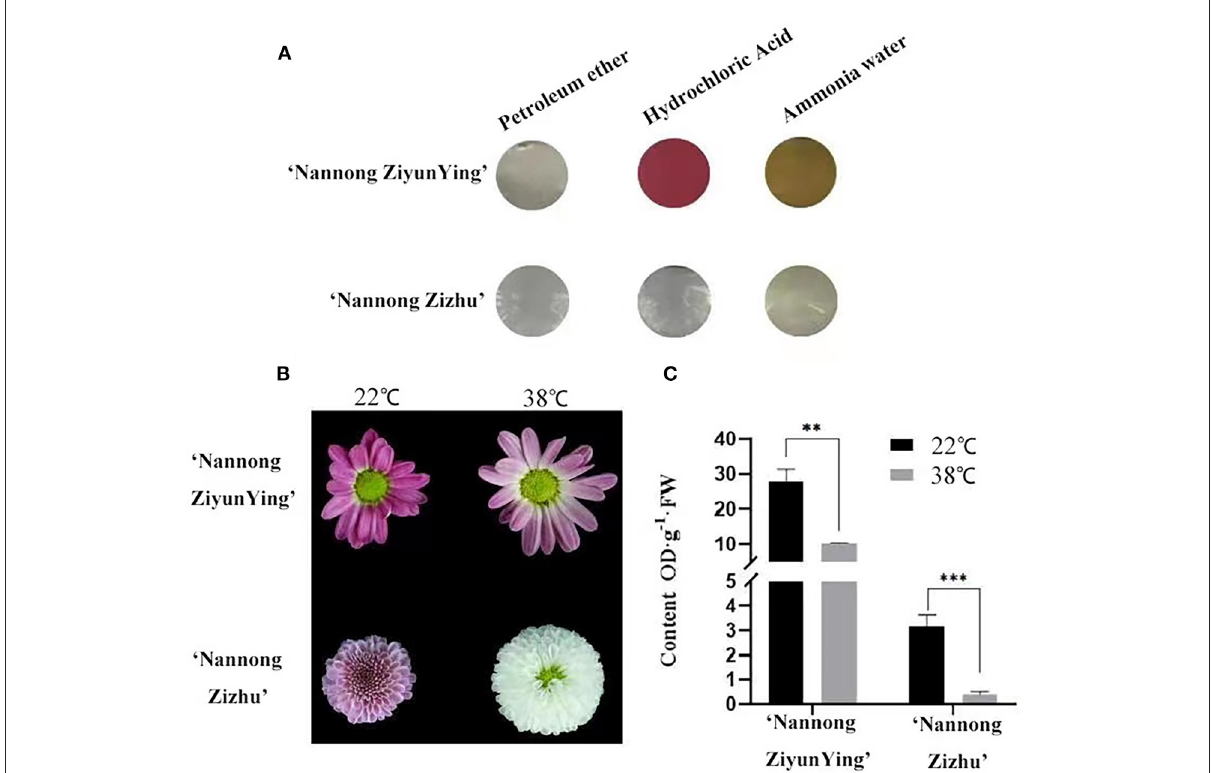
FIGURE2 Qualitative analysis of anthocyanin types and content in two cut chrysanthemum cultivars. (A) Calibration of anthocyanin components. (B) Comparison of high-temperature-treated and untreated flower color phenotypes. (C) Anthocyanin content of high-temperature treated and untreated cultivars. Error bars represent standard deviations from three biological replicates. Values are presented as mean ± SE ( n = 3). **Significant at P < 0.01 and ***extremely significant at P < 0.001, as determined by Student’s t